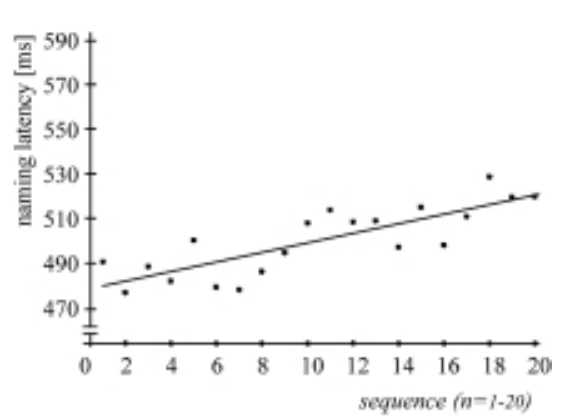
Fig. 5. The observed facilitatory effect on naming latency [23] vanished in a gradual manner over the first 30 s after the end of the high-frequency train ( p < 0 . 05 ).